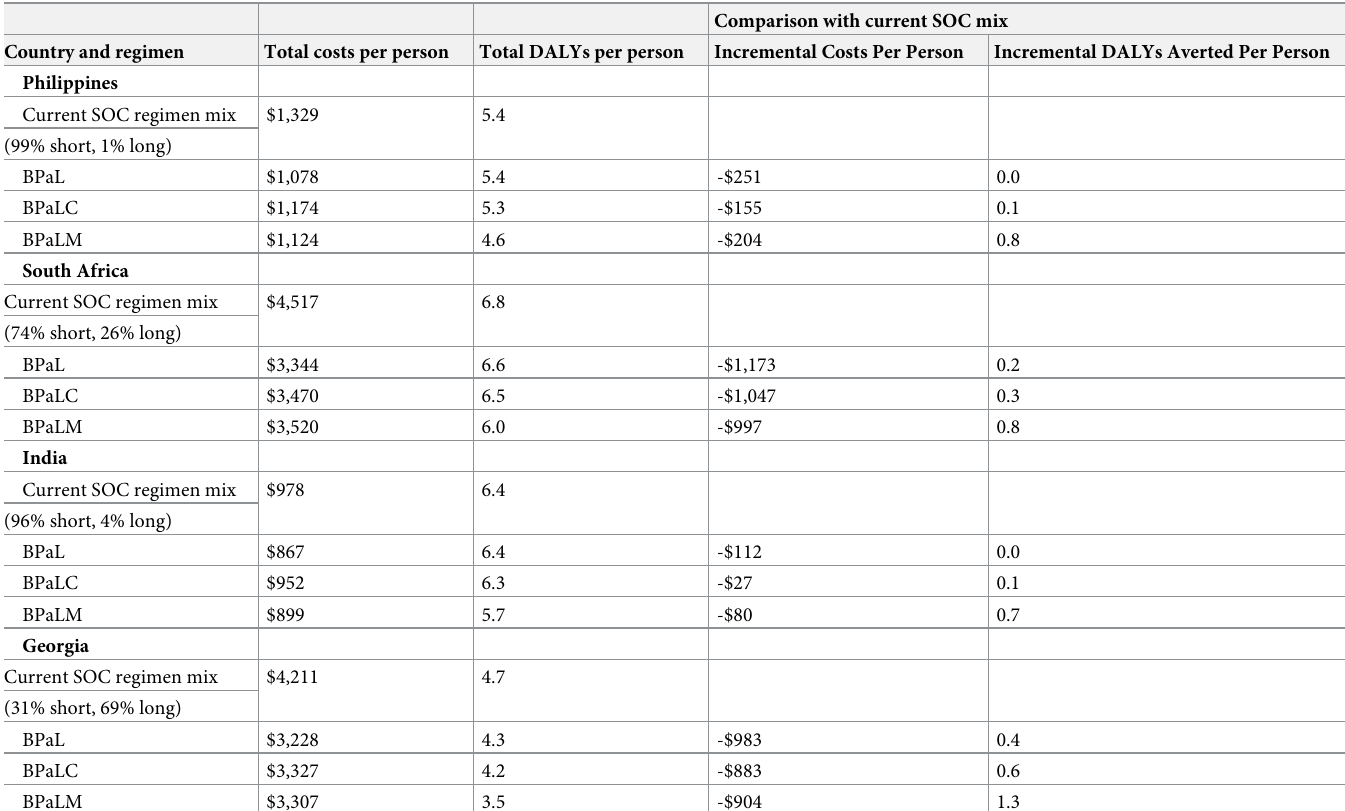
Table 2. Base case